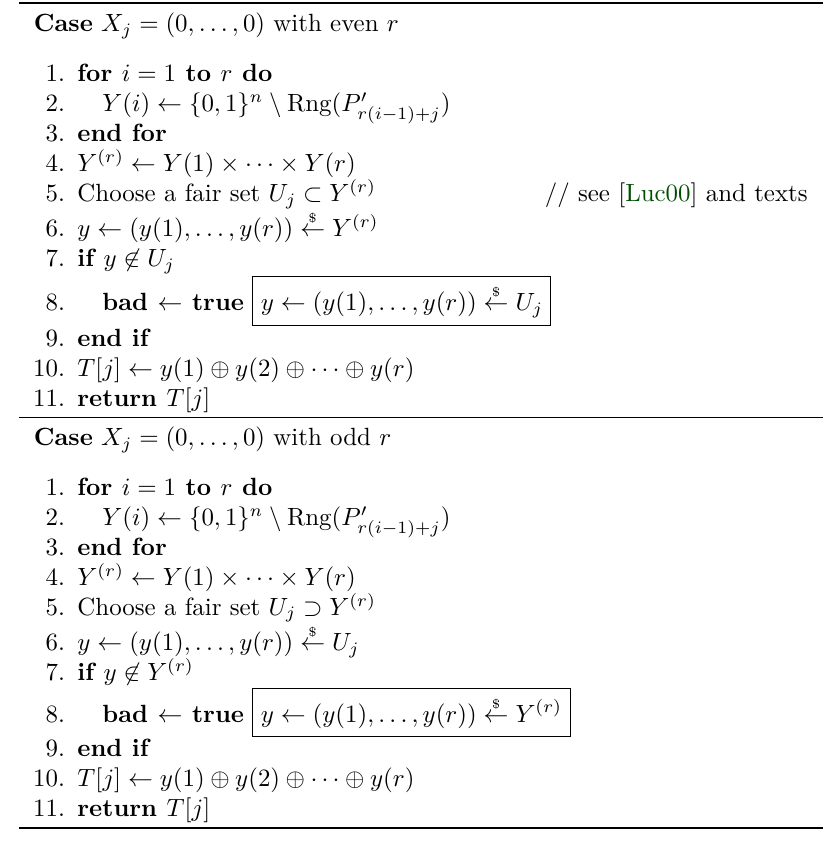
Figure 9: Case X j = (0 , . . . , 0). When r is even, the boxed argument is only for the ideal game, and when r is odd, the boxed argument is only for the real